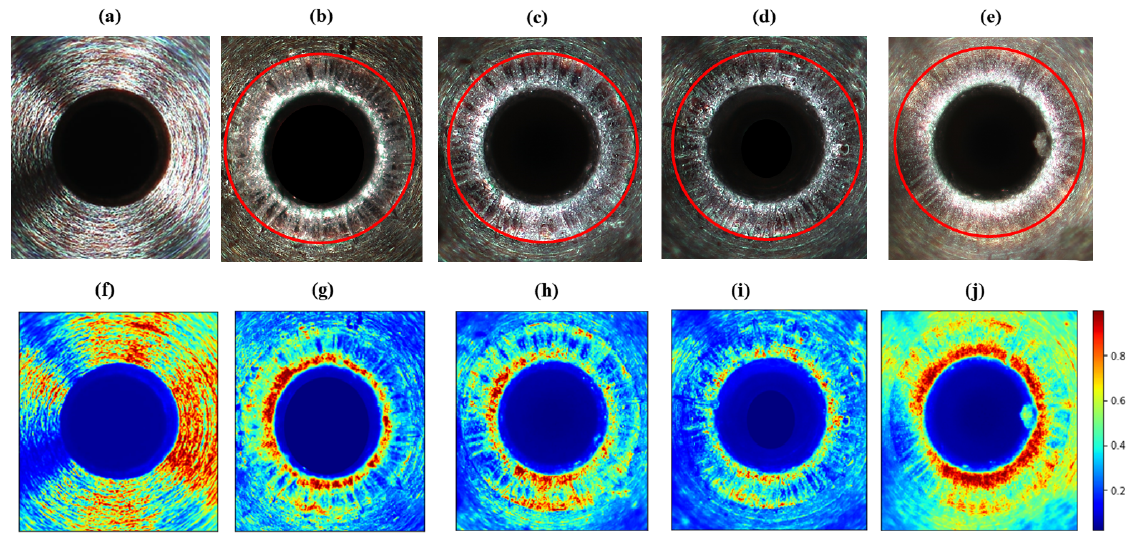
Figure 8. Comparison of injector valve ball seats between ( a ) normal injector, ( b – e ) worn injectors after experiment, and ( f – j ) surface profiles for respective injector valve